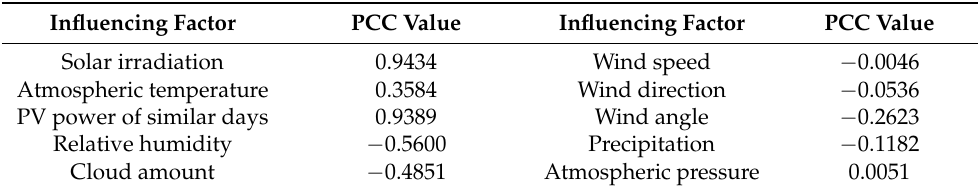
Table 1. PCC values between influencing factors and PV